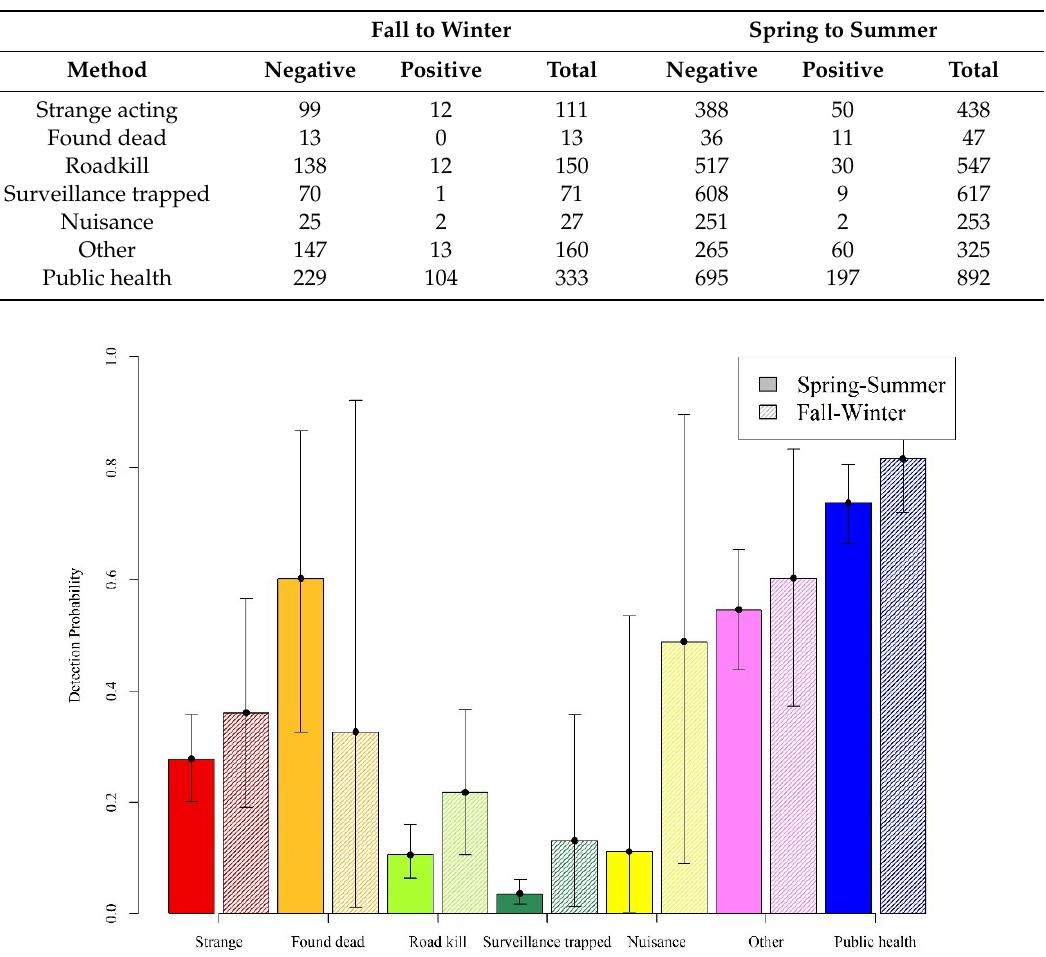
Table 2. Number of negative and positive RABV samples and total raccoon samples from 2006 to 2017 in northeastern U.S. by the surveillance method.